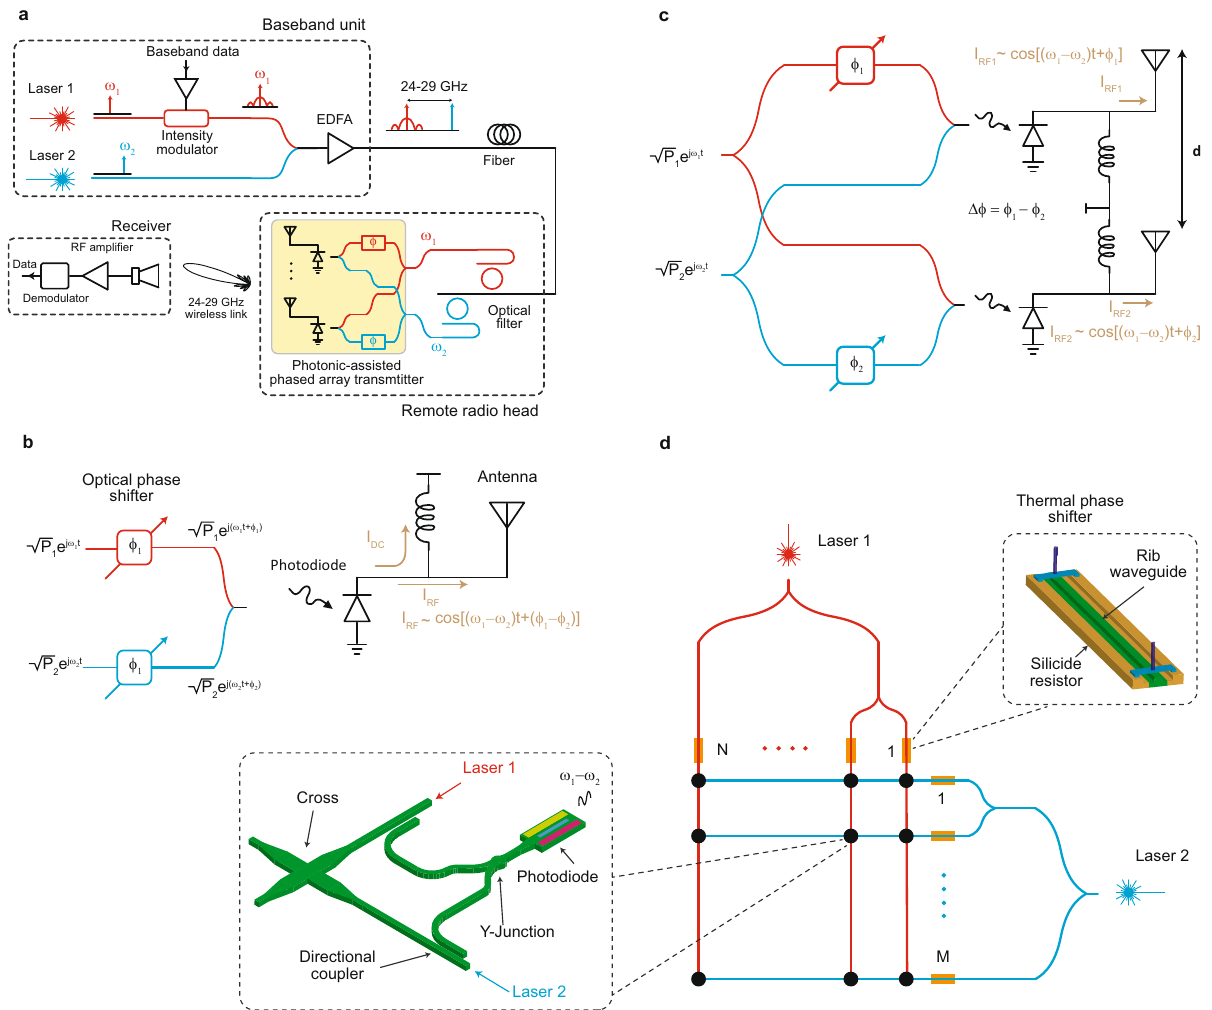
Fig. 1 | Photonics for mm-wave beam formation and generation. a A potential fi ber to mm-wave front haul architecture with remote heterodyne detection employing a photonic - assisted phased array transmitter. b Optical heterodyning scheme used to generate mm-wave signal with the photodiode directly driving an antenna. c Illustrationofatwo-elementphasedarrayusingopticaldistributionand beam formation. d M × N matrix architecture with path sharing used to reduce the number of phase-shift elements. The inset on the right shows the architecture of the thermal phase shifter where the central partof a rib waveguide con fi nes the